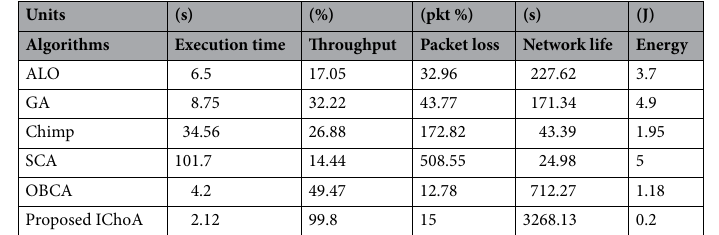
Table 12. Performance evaluation of various optimization algorithms simulated for 100 nodes wireless sensor